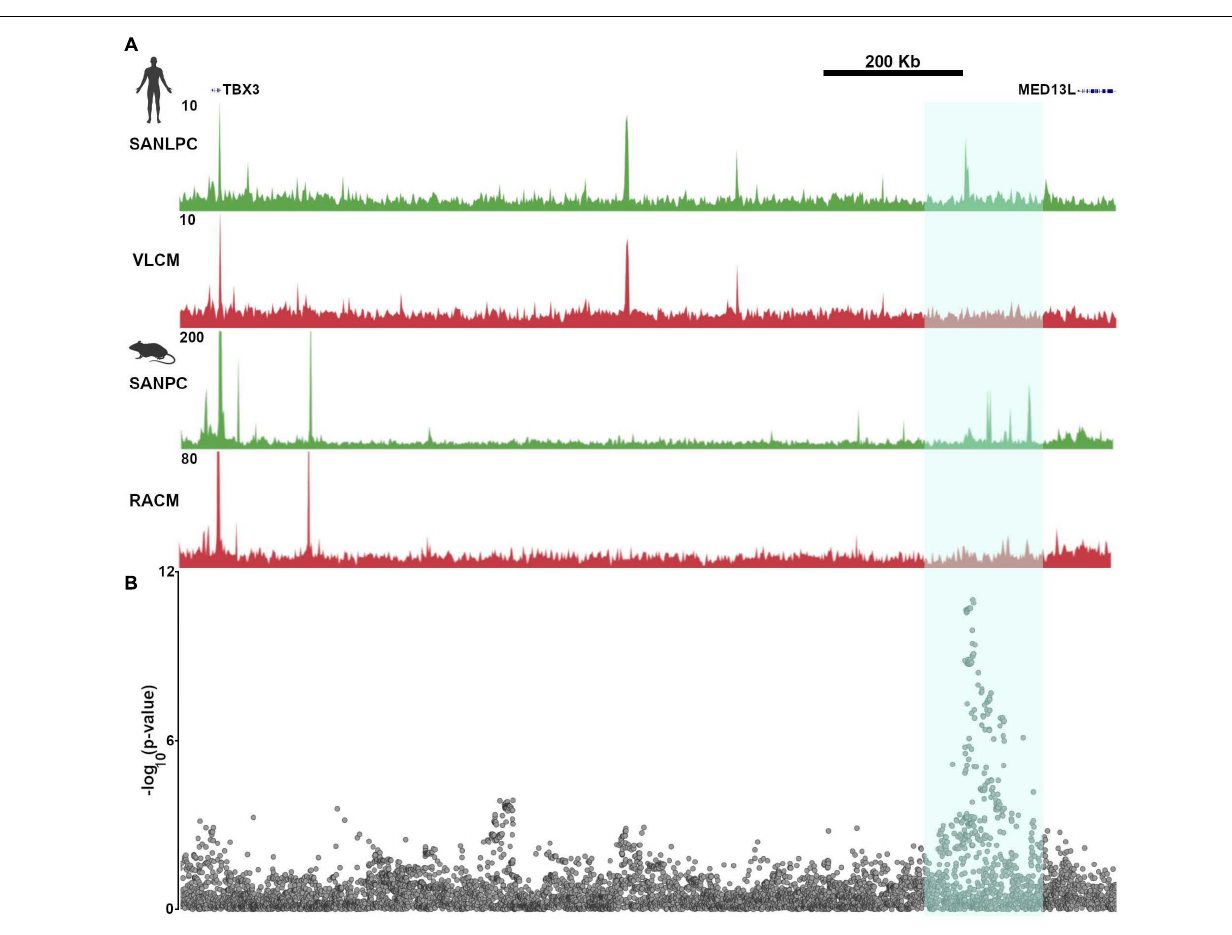
FIGURE 6 | Common genetic variants in pacemaker cell enhancers affect sinoatrial node function in human populations. (A) Aligned SAN ATAC-seq data from human iPSC-derived pacemaker-like cells (SANLPC) and ventricular like cells (VLCM) with syntenic genomic region from mouse sinoatrial node pacemaker cells (SANPC) and right atrial cardiomyocytes (RACM) demonstrate differentially accessible chromatin regions shared by both sets of pacemaker cells (highlighted in cyan). (B) shows alignment of a resting heart rate GWAS at the TBX3 locus, with highly significant associations seen in the region with differentially accessible ATAC-seq peaks, underscoring the relevance of SAN enhancers to human sinoatrial node function. GWAS results were downloaded from